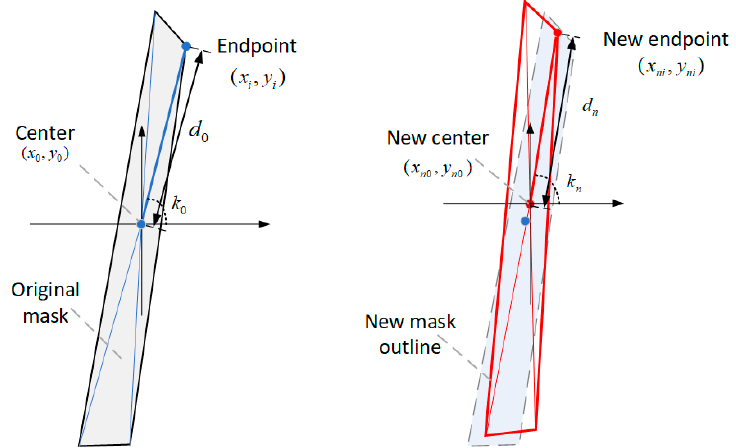
Figure 7. Schematic diagram of mask transformation principle.